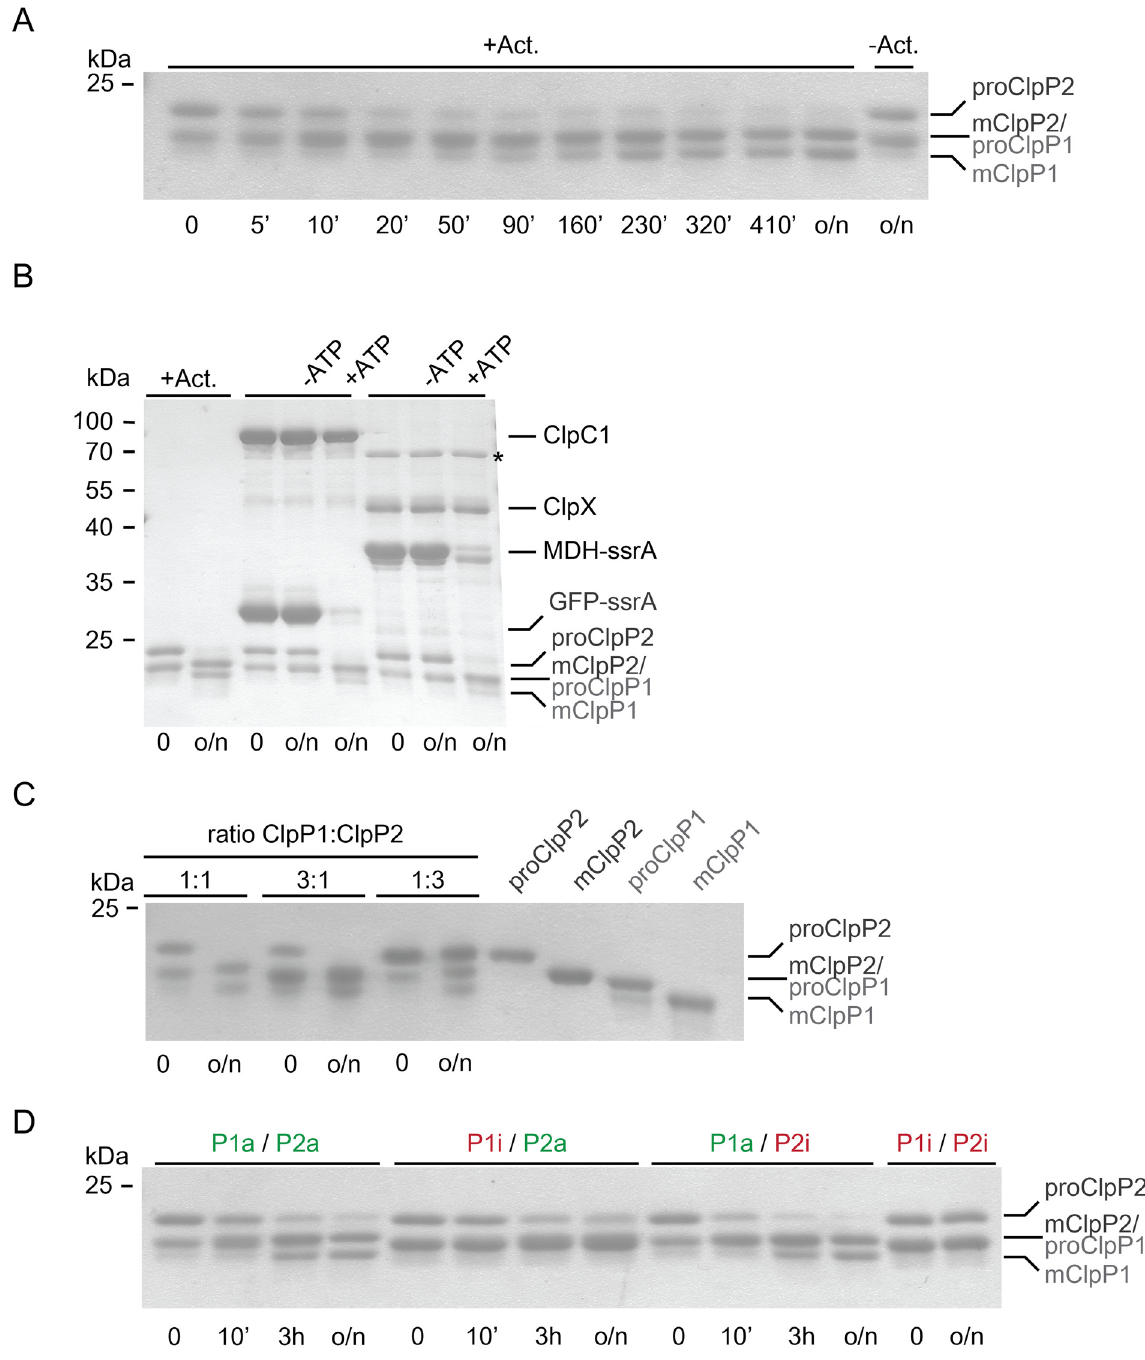
Fig 2. Propeptide processing of ClpP1 and ClpP2 in the ClpP1P2 double-ring assembly. Maturation of double-ring assembled ClpP1 and ClpP2 carrying the N-terminal propeptide (proClpP1, proClp2) to the mature proteins (mClpP1, mClpP2) was performed at room temperature and followed by SDS-PAGE analysis. Samples were taken at the indicated time points. A. Propeptide processing of ClpP1 and ClpP2 (25 μ M protomer each), in the presence of 1 mM activator (+Act.), or without activator ( − Act.). B. Propeptide processing of ClpP1 and ClpP2 (0.5 μ M double-ring particle) in the absence of activator and the presence of 1 μ M ClpC1 hexamer, 10 μ M GFP-ssrA or 1 μ M ClpX hexamer and 10 μ M MDH-ssrA, and 5mM ATP (+ATP) or without ATP ( − ATP). For comparison, overnight processing of ClpP1 and ClpP2 in the presence of 1 mM activator is shown. The asterisk ( * ) indicates a protein contaminant that was identified by mass spectrometry to contain DnaK from E . coli . C. Propeptide processing of ClpP1 and ClpP2 at different molar ratios of ClpP1:ClpP2 with 25 and 75 μ M, respectively, ClpP1 or ClpP2 protomer concentration in the presence of 1 mM activator. D. Propeptide processing of double-ring complexes assembled from wild-type (active) ClpP1 and ClpP2 (P1a, P2a, 25 μ M protomer each) and protease-inactive ClpP1 S98A , ClpP2 S110A (P1i, P2i) in the presence of 1 mM